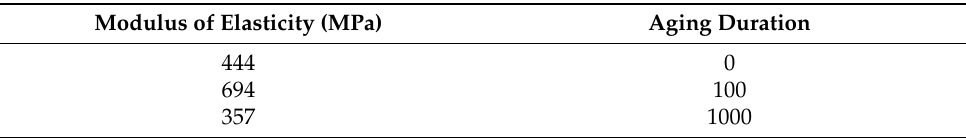
Table 2. Modulus of elasticity vs. thermal aging